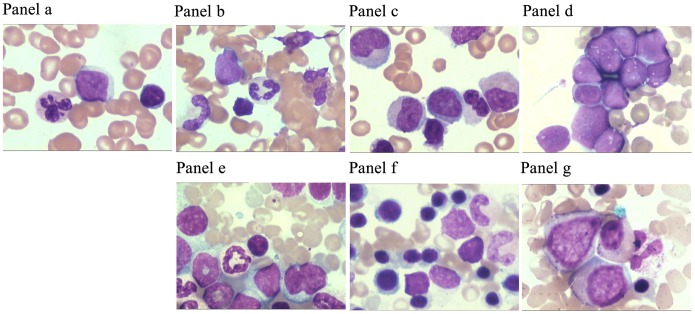
The distribution characteristics of erythrocytes in BM at 3d after exposed by different doses of 12C6+ ions or X-rays.Cytology analysis the distribution of erythrocytes in BM. In detailed, Panel a: Non-irradiated control group erythrocytes (0Gy); Panel b–d: erythrocytes of carbon ions radiation groups (Radiation dose: 2Gy, 4Gy and 6Gy); panel e–g: erythrocytes of X-rays radiation groups (Radiation dose: 4Gy, 6Gy and 12Gy). And BM aspirate smear from irradiated golden hamster showing abnormal erythroblasts indicative of a cell-division defect, or dysplasia. The cytology image was observed with 100×oil immersion, in the picture, pink represents the erythrocytes.